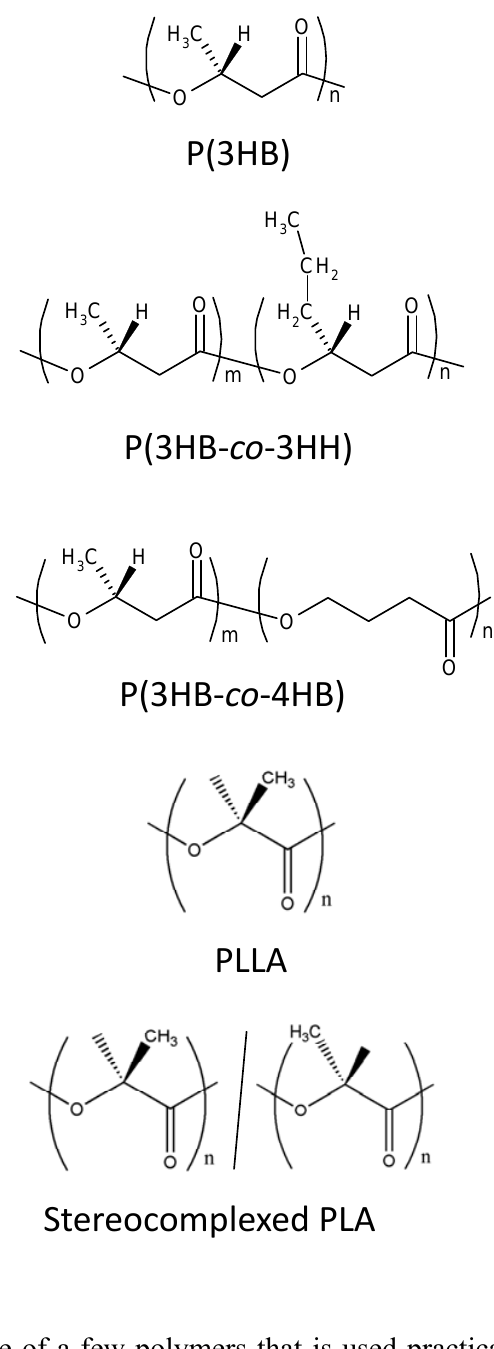
Figure 1. Chemical structures of PHAs, PLLA and stereocomplexed